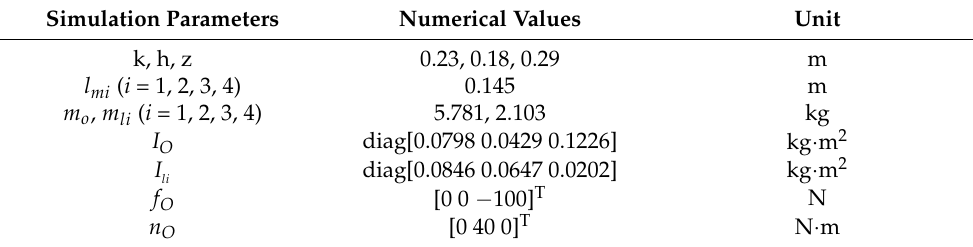
Table 1. Geometric and inertial parameters of the